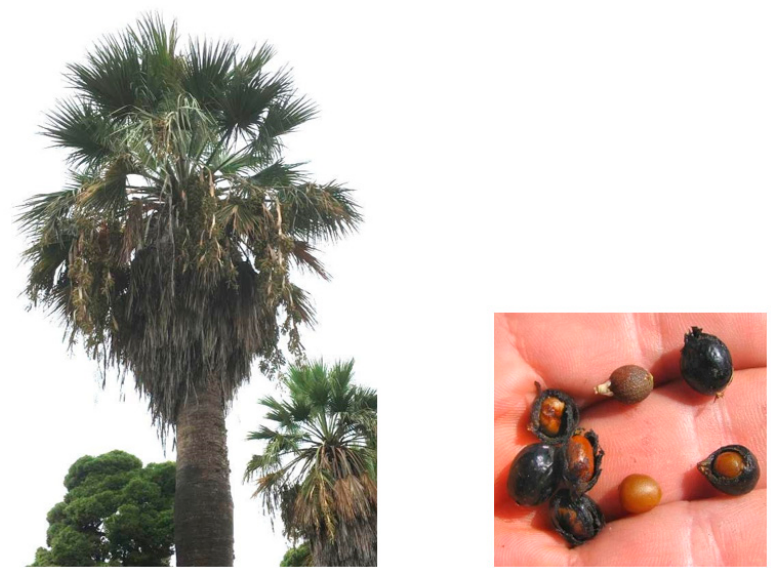
Figure 1. Washingtonia filifera ( left ) and its fruits ( right ), where pulp and seeds are well visible. W. filifera has been studied regarding, for example, its use as a potential source of